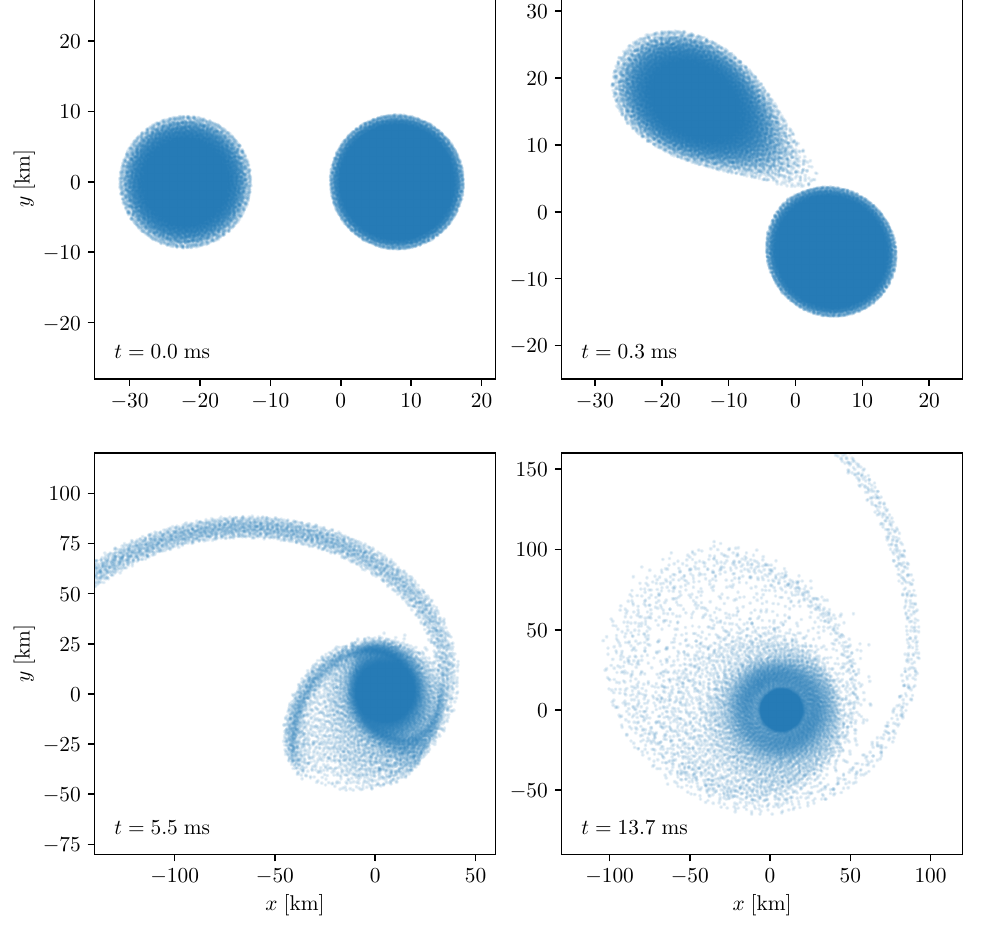
and M 2 = 0.5 M . The initial (cid:12) (cid:12) y plane −